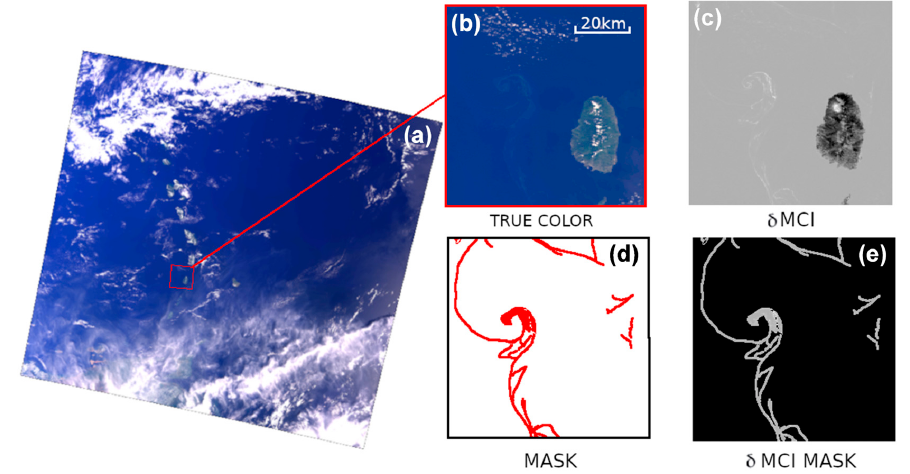
Figure 4. ( a ) OLCI image on 23 February 2017 with True color composite (band 9:674 nm:Red; band 7:560 nm:Green; Band 2:413 nm:Blue). ( b ) Sub-image example (red square); ( c ) δ MCI; ( d ) binary mask manually made using several indexes and ( e ) masked δ MCI built using the binary